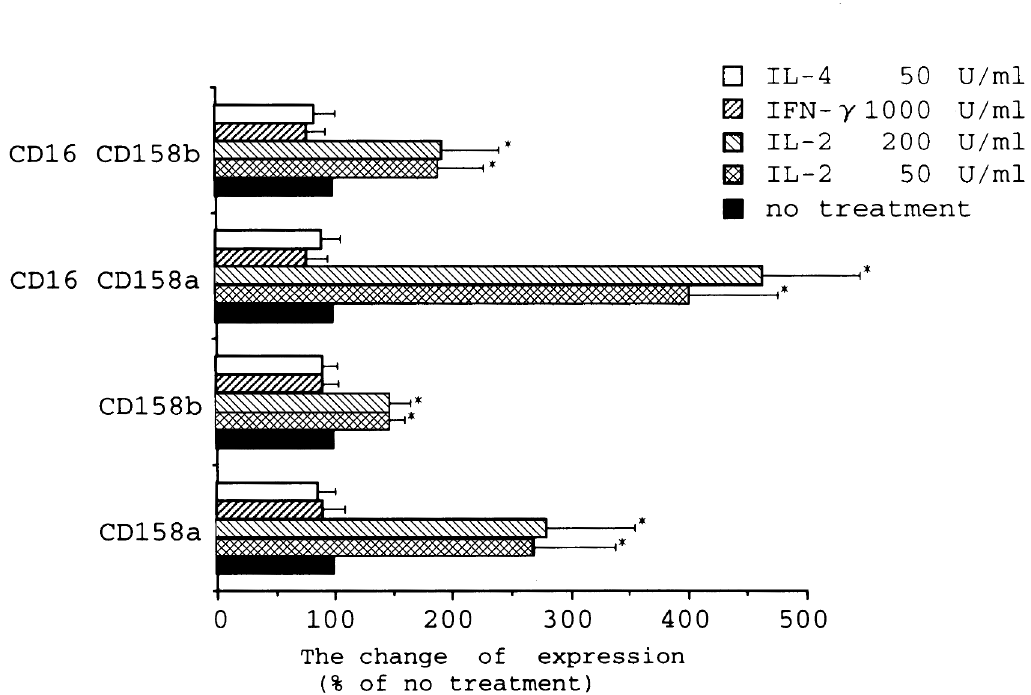
FIG. 2. Regulation of KIRs on PBMC by several cytokines. The cells were incubated in a humidified 5% CO 2 /95% air atmosphere at 37°C for 48h without cytokine, or with IL-2 (50 or 200U/ml), IL-4 (50U/ml), or IFN- g (1000U/ml). Neither IL-4 nor IFN- g affected the expression of CD158a/b, but IL-2 upregulated their expression on lymphocytes. Asterisks indicate a significant increase compared to no treatment in each group with a P value of < 0.05. Data are shown as the mean (thick bar) ±SD (thin